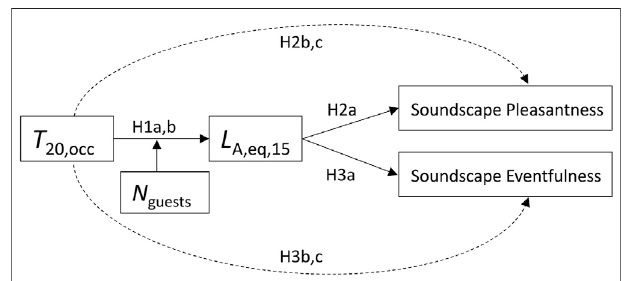
FIGURE 1 | Hypothesized relationships between object- and subject- centred acoustical variables obtained in our study.